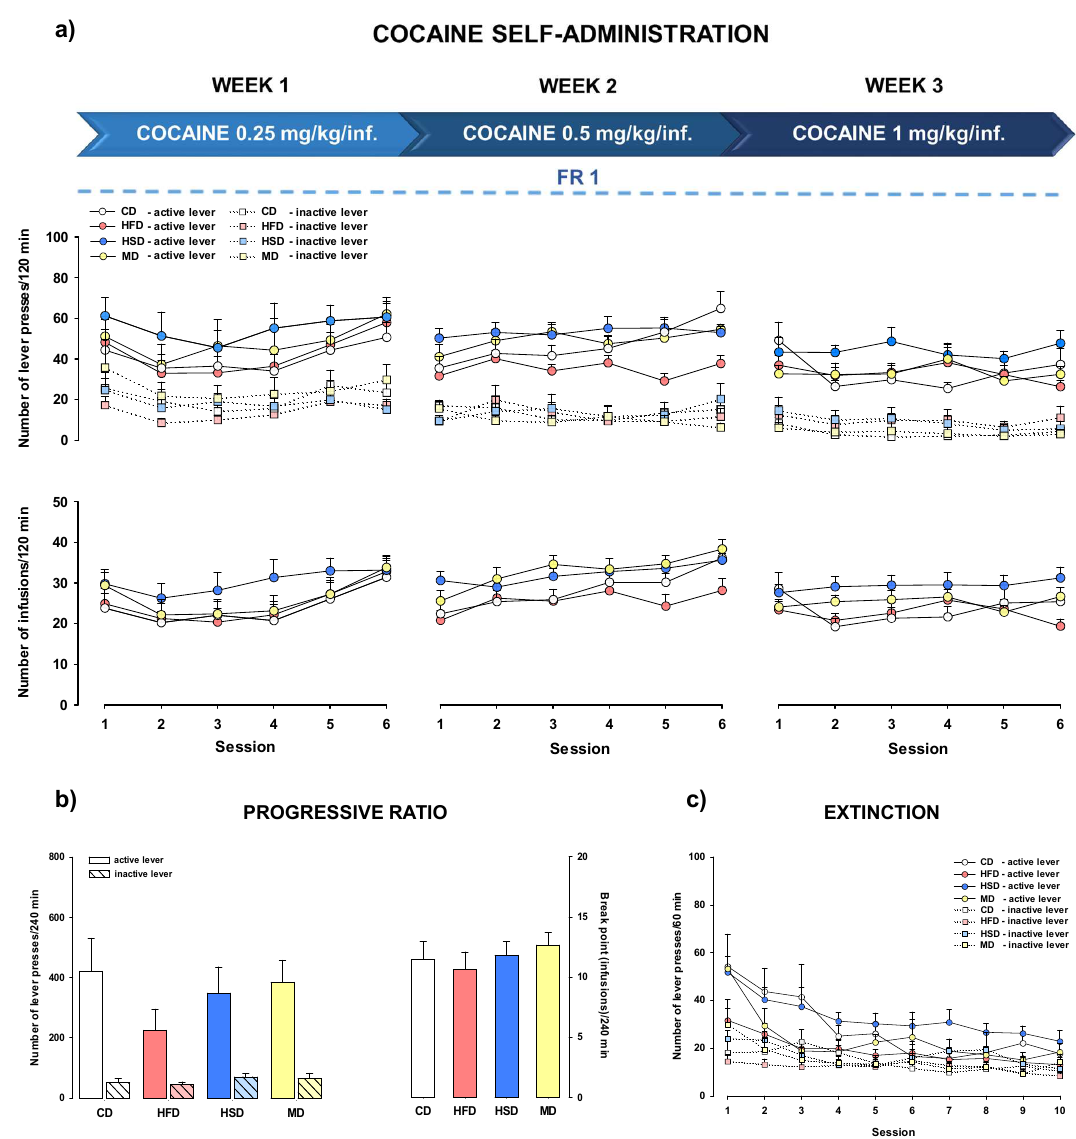
Figure 4. ( a ) E ff ects of a maternal high-fat (HFD), high-sugar (HSD), or mixed (MD) diet during pregnancy and lactation on the acquisition / maintenance of cocaine (0.25–1 mg / kg / infusion) self-administration with a stable FR1 schedule of reinforcement in female o ff spring rats. ( b ) E ff ects of the modified maternal diets on cocaine self-administration with a progressive ratio schedule in female o ff spring day after the last session of cocaine self-administration with a stable FR1 schedule of reinforcement and an increasing dose of cocaine (0.25–1 mg / kg / infusion). ( c ) E ff ects of the modified maternal diets on self-administration extinction with increased doses of cocaine (0.25–1 mg / kg / infusion) and a stable FR1 schedule of reinforcement in female o ff spring rats. Numbers of active and inactive lever presses and cocaine infusions are expressed as the mean ( ± SEM). The number of animals in each group was as follows: cocaine self-administration CD ( n = 12), HFD ( n = 11), HSD ( n = 11), MD ( n = 12); extinction training CD ( n = 11), HFD ( n = 10), HSD ( n = 10), MD ( n = 12). CD, control